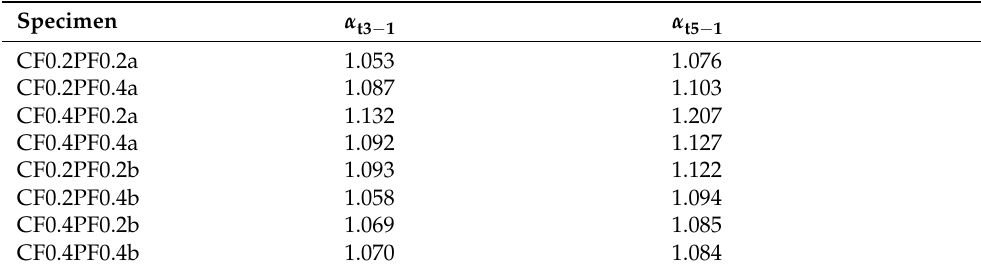
Table 7. Specific toughness synergistic coefficient.